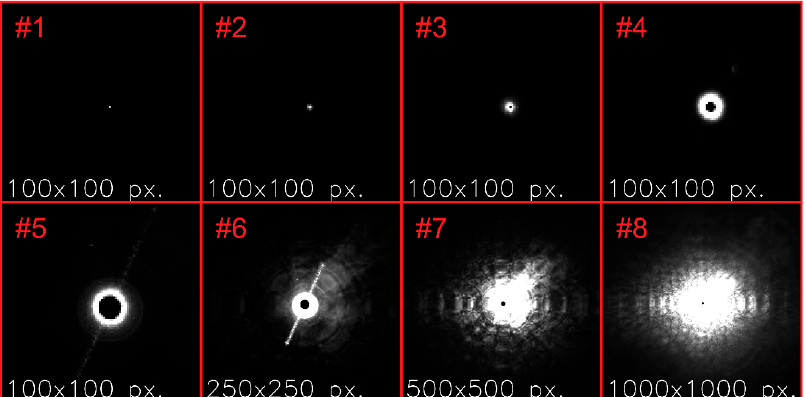
Figure 6. Examples of camera images acquired for di ff erent values of exposure time and laser power. The labels correspond to the setting numbers of Table 4. Camera lens: Edmund Optics 86410, experimental parameters: λ = 488 nm, F =